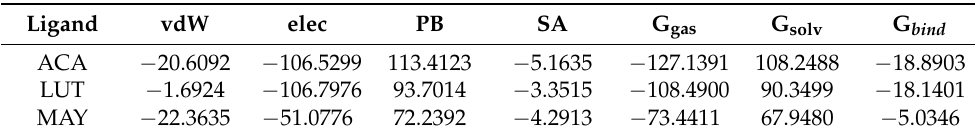
Table 5. Binding free energy contributions for ACA, LUT, and MAY complexes. All energies are in